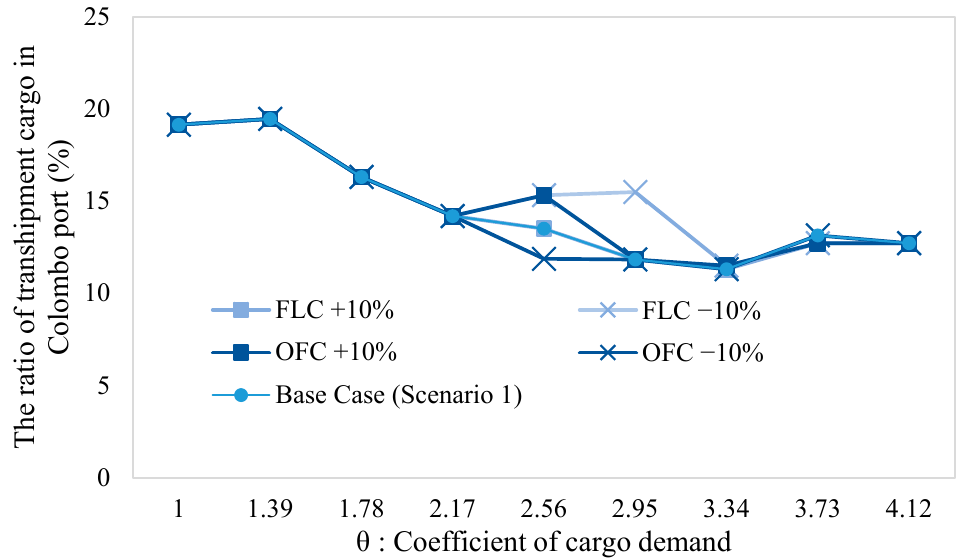
Figure 4. The ratio of transhipment cargo in Colombo port by changing FLC and OFC.